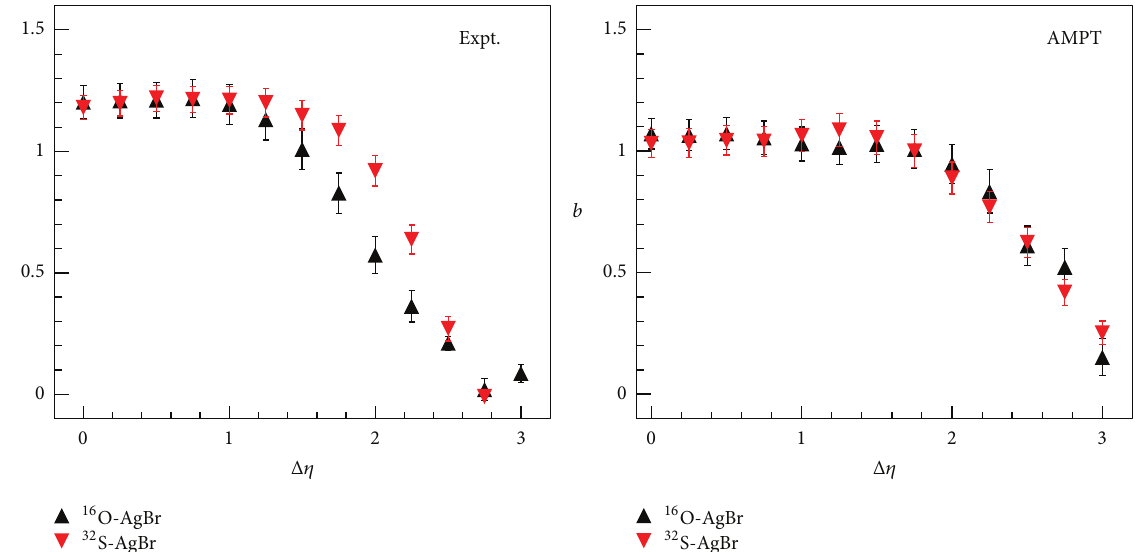
Figure 4: Variations of 𝑏 with Δ𝜂 for 16 O- and 32 S-AgBr collisions.